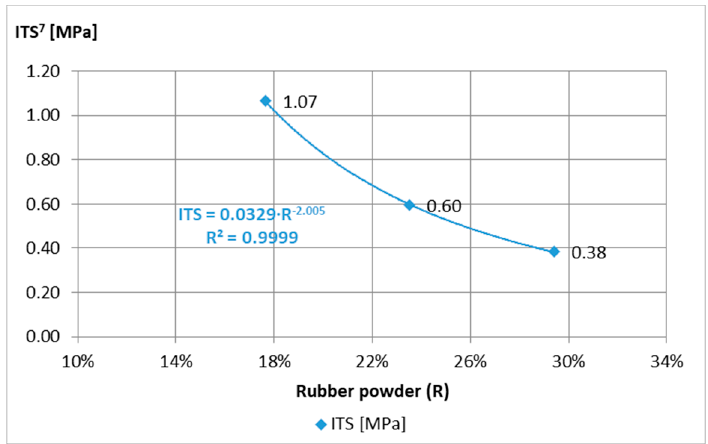
Figure 3. Indirect tensile strength ITS of mortar samples Ø100 mm × 63.5 mm depending on the amount of rubber powder, tested at the temperature of 5 °C, after 7 days of curing.